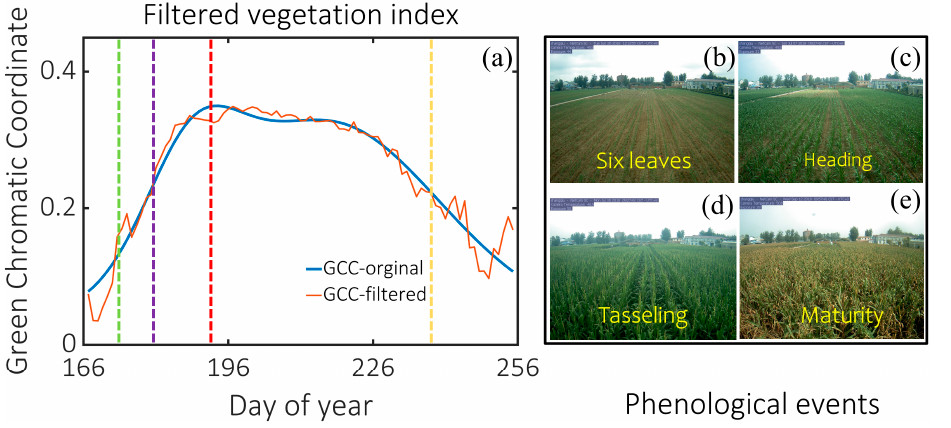
Figure 2. The definition of maize phenology according to the temporal dynamic of the vegetation index. Note: The curves of the original and filtered GCC by DLF for the site Shangqiu in 2018 are the orange and blues solid lines in ( a ). The green, purple, red and yellow dash lines in ( a ) are in accordance with ( b – e ), representing different maize phenological aspects, respectively.